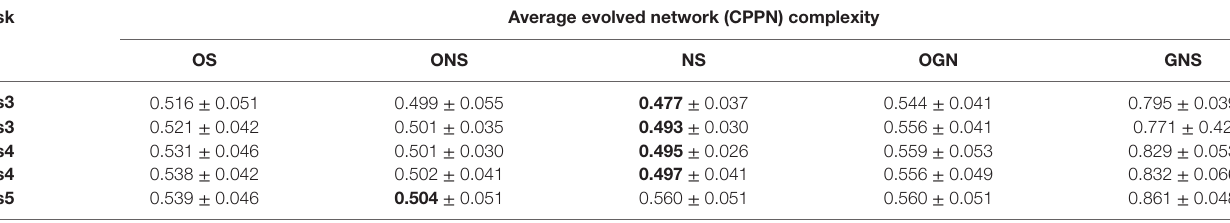
TaBle 6 | Average normalized complexity of CPPNs corresponding to fittest evolved behaviors, for each HyperNEAT variant and each keep-away task, given behavior transfer.